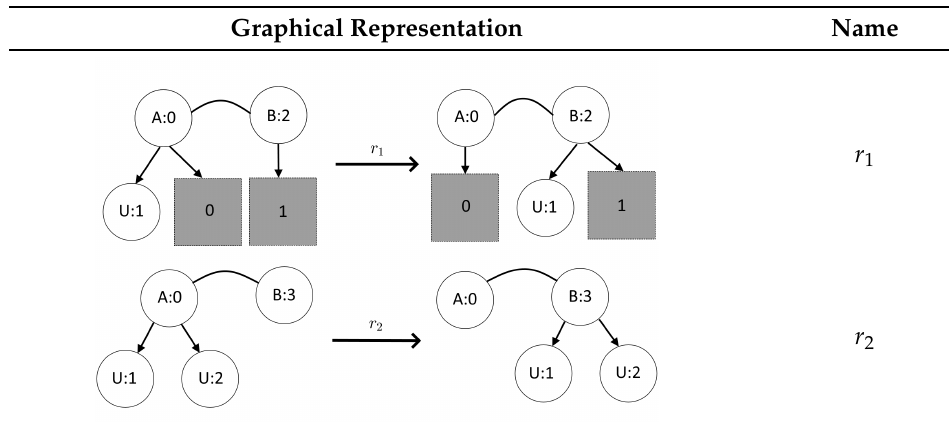
set for the introductory example. The η function for the first rule and Table 2. Elements of the R both τ functions are identities. The first rule represents an action that allows a single agent to move between areas. The second rule is for an action where two agents move both at once. The second rule is only reasonable if underlying mechanism differs to that of the first